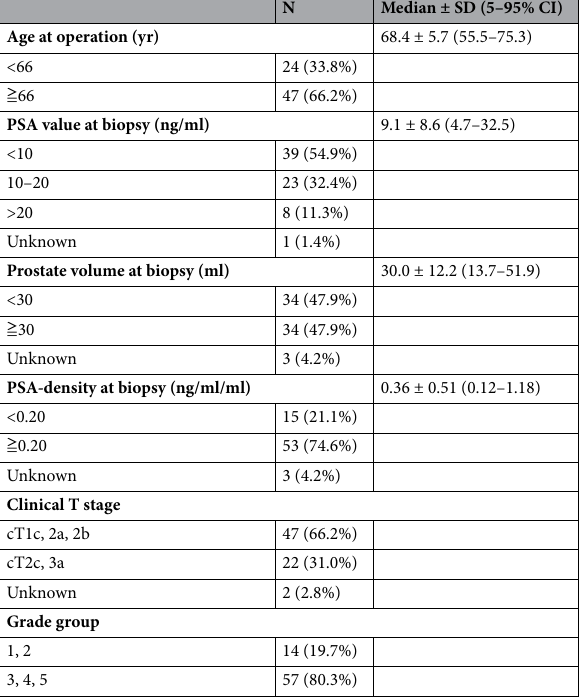
Table.1. Patient’s